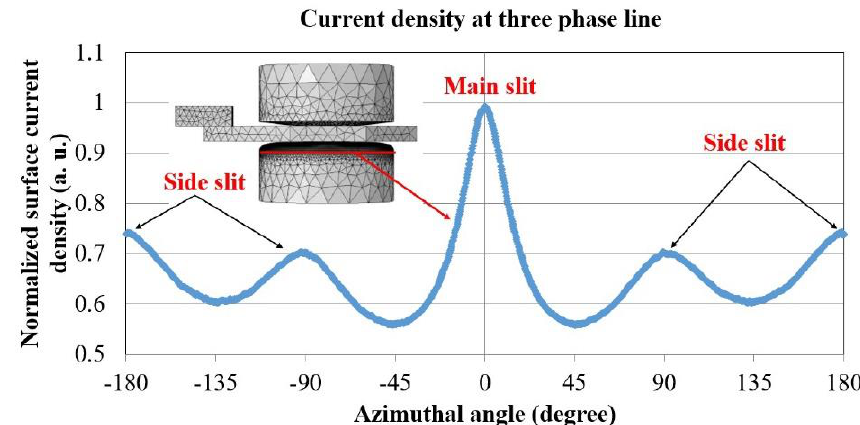
Figure 4. Surface current density distribution along the three-phase line. Azimuthal angle of the main slit is regarded as 0°. The angles of the three side slits are −90°, 90°, and 180°, respectively.